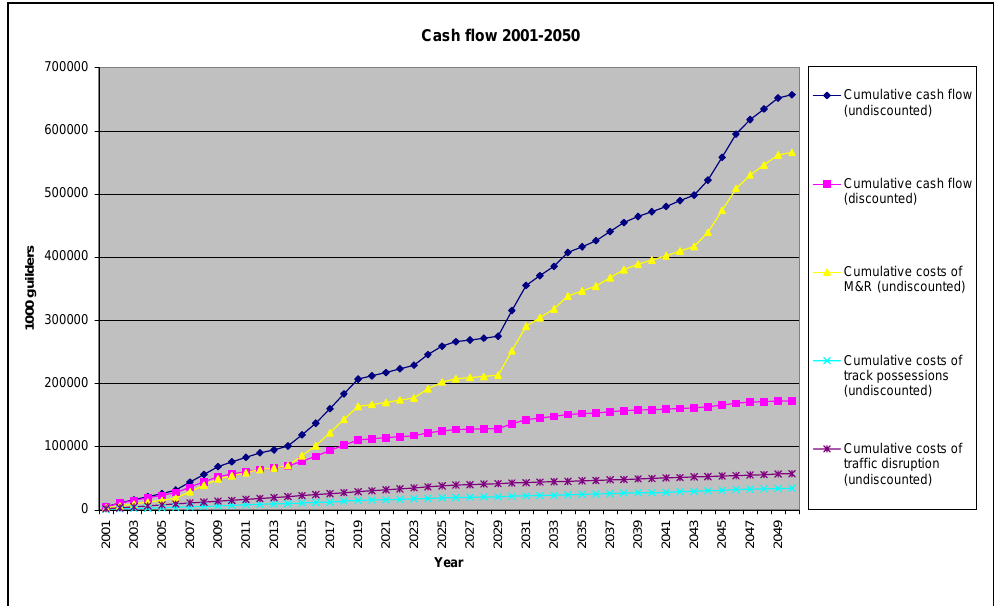
Figure 6. Cash flows during the period of analysis, intermediate result after step